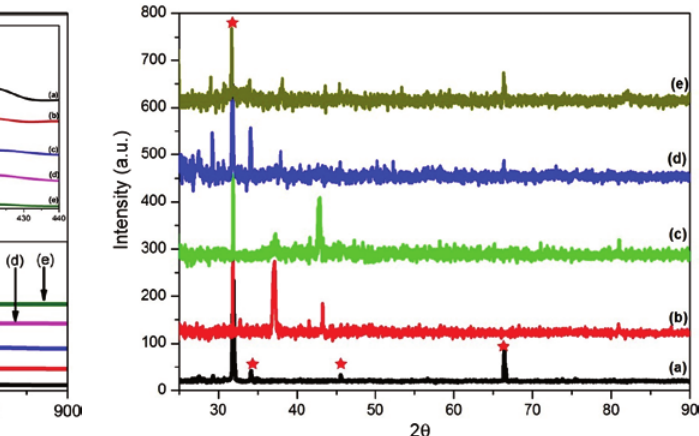
Figure 7: Absorption [A] and emission [B] spectra of the PDD (a) and PDD incorporated with the blank (b) ZnS nanoparticles capped with (c) 1%, (d) 3%, and (e) 5% PEG.